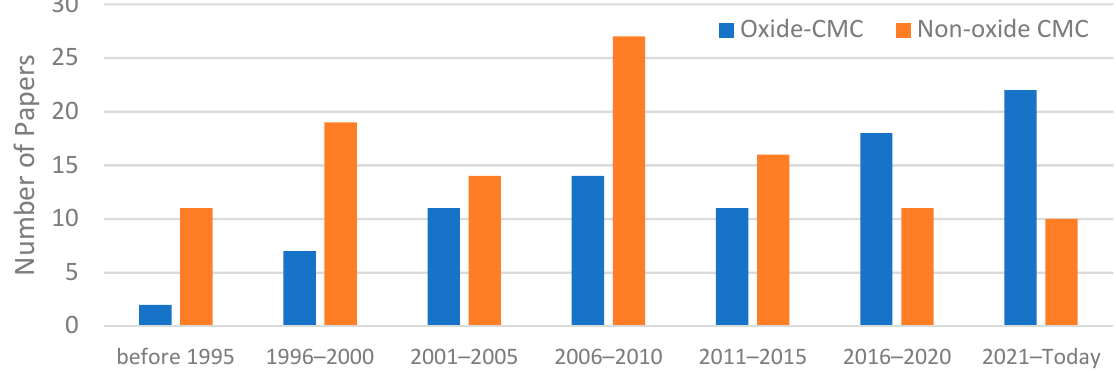
Figure 3. Oxide vs. non-oxide CMC materials research.